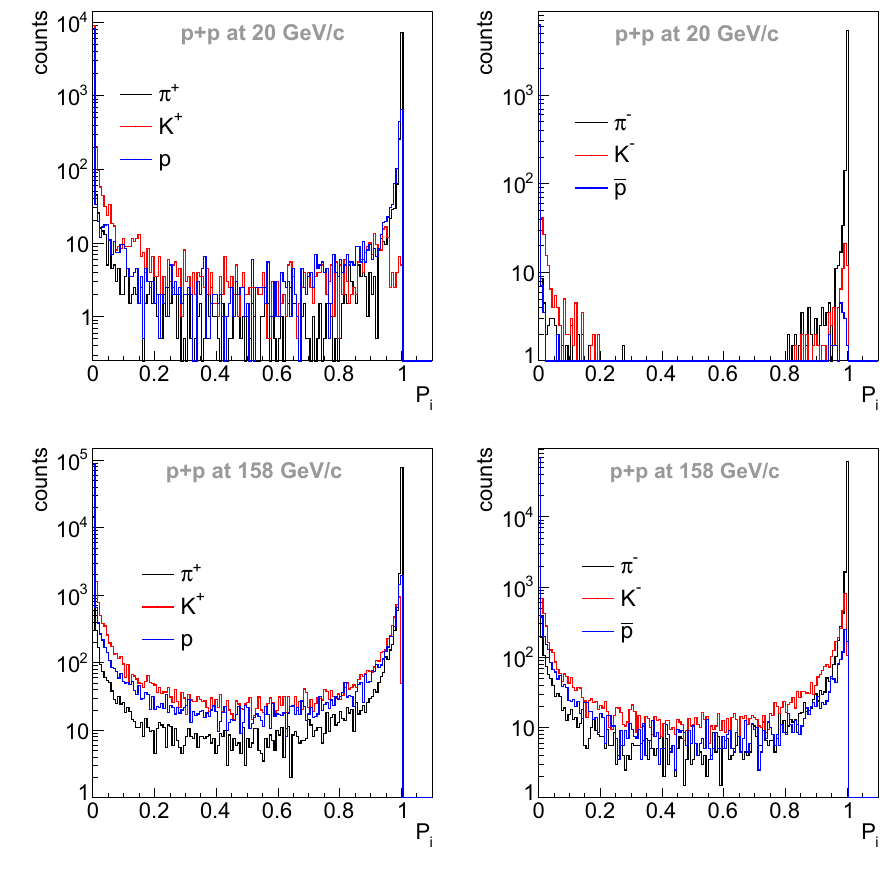
Table 3 Measured fraction of out-of-target events in recorded p + p interactions at SPS energies Beam momentum (GeV/c)